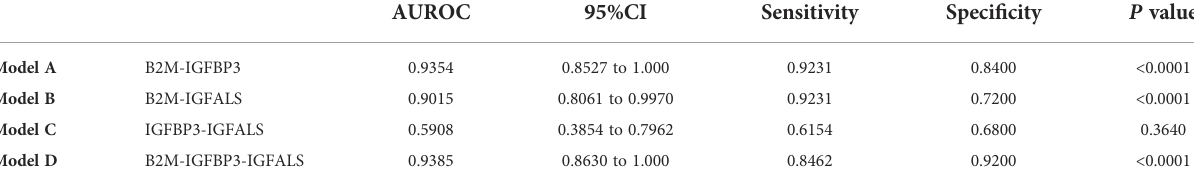
TABLE 6 Characteristics of diagnostic models ROC curves for non-severe